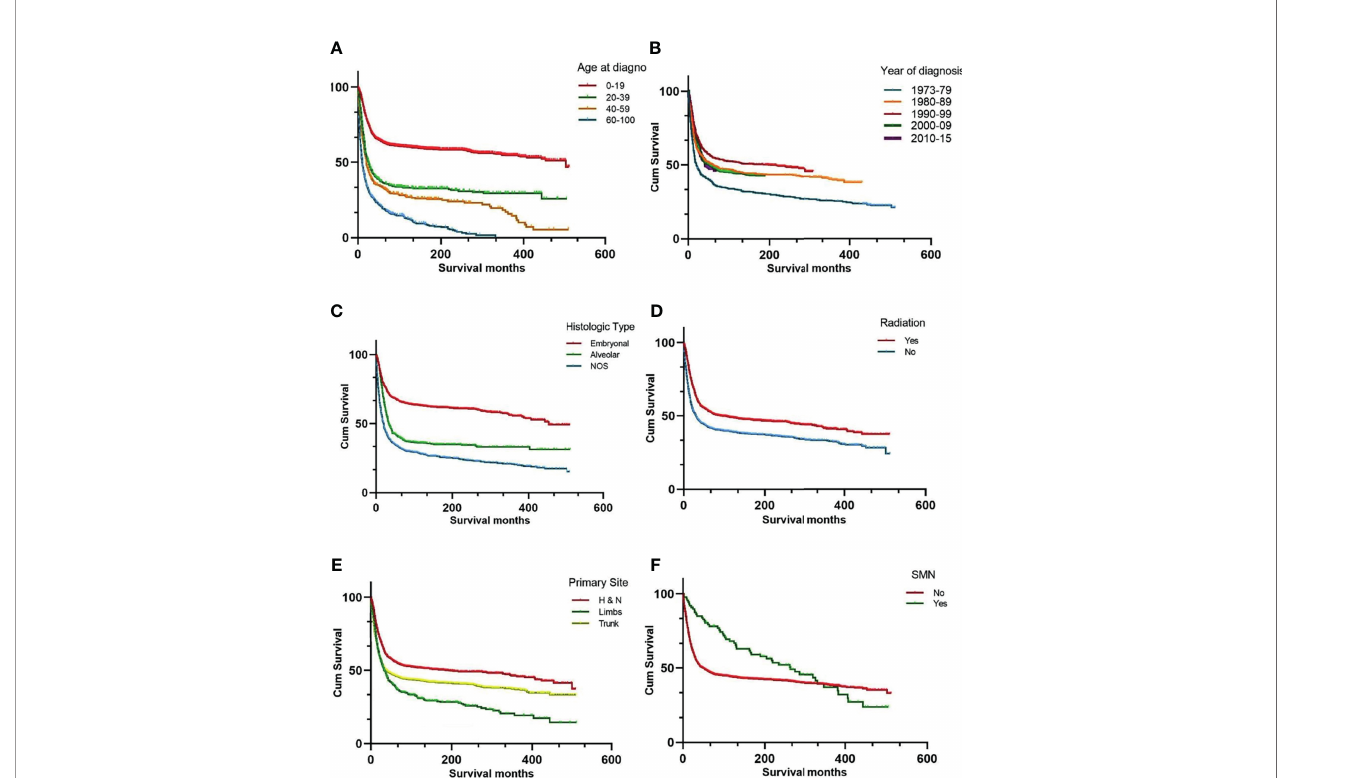
FIGURE 1 | Kaplan-Meier curves of overall survival strati fi ed by age at diagnosis (A) year of diagnosis (B) histologic subtypes (C) radiation therapy (D) primary site (E) and SMN (F) . SMN, second malignant neoplasm; NOS, not otherwise speci fi ed.